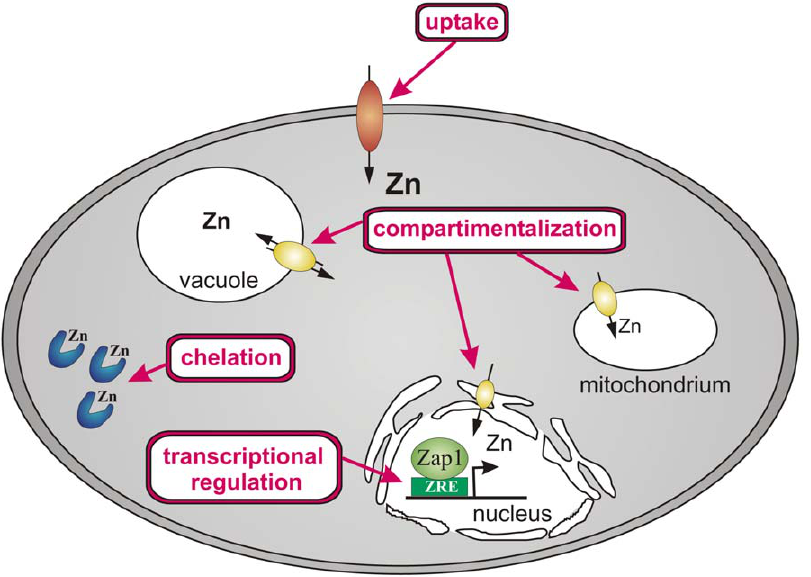
Figure 8. Summary of mode of action. The cell model shows the four potential mechanisms of action for hit compounds to interfere with zinc homeostasis. Hit compounds can inhibit zinc uptake transporter, induce the formation of chelators or act as chelators themselves, interfere with zinc transport in or out of compartments, or modulate zinc transcription factors like Zap1.